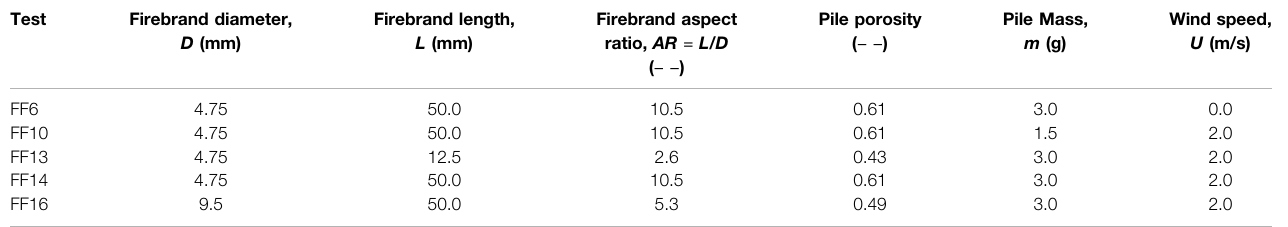
TABLE 12 | Tests to compare the effects of different fi rebrand pile parameters on the heat fl ux distribution with